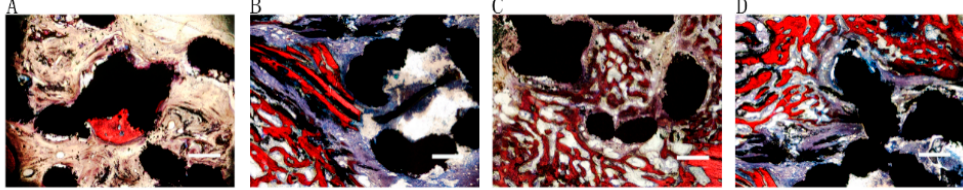
Figure 6. Histological analysis of hybrid implants osteointegration ability in control group ( A ) Gel:nHA = 1:0 group; ( B ) Gel:nHA = 1:1 group; ( C ) Gel:nHA = 1:3 group; ( D ) by Van Gieson staining at 12 weeks. (red indicated new bone formation, blue represented fibrous tissue and black showed the metal). Scale bar: 500 μ m.